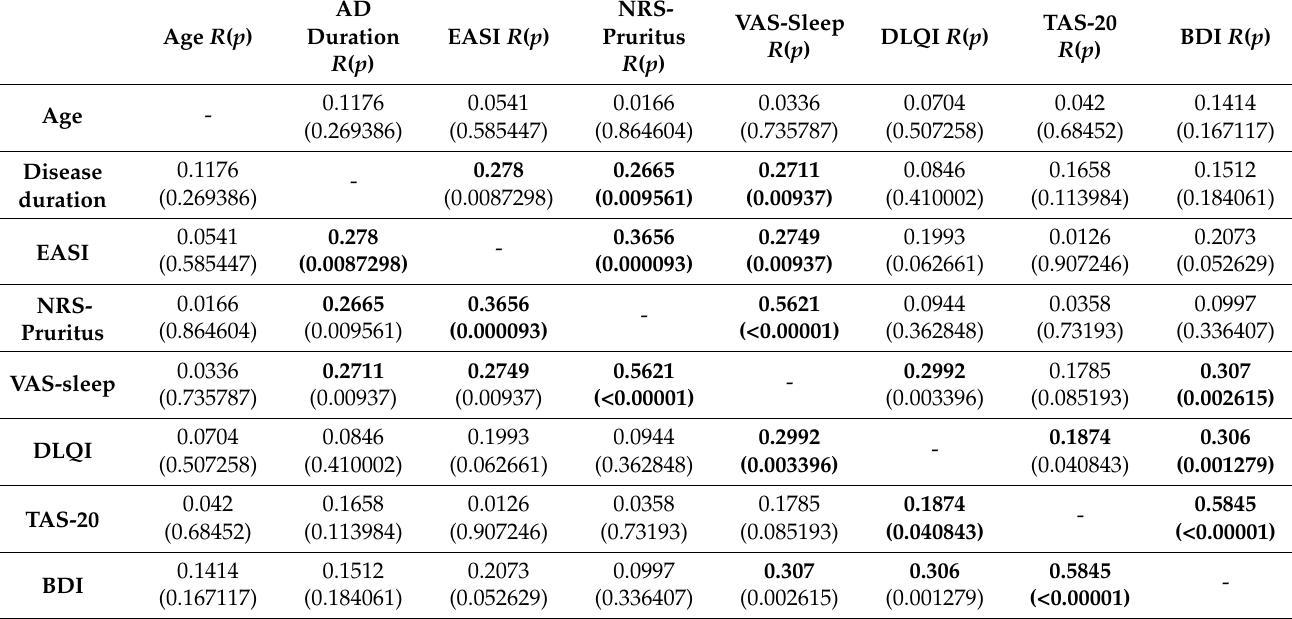
Table 7. Correlations between psychometric assessments and the clinical parameters